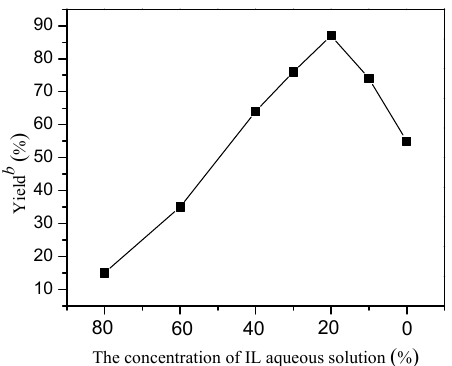
Figure 2. Reaction yield in IL aqueous solutions with different concentrations a . a Reaction conditions : 2-aminoacetophenone (0.3 mmol), ethyl acetoacetate (0.36 mmol), and α -chymotrypsin (10 mg) in IL aqueous solutions of different concentrations (80 to 0%, [EMIM][BF 4 ]/(H 2 O + [EMIM][BF 4 ]), v / v ) at 60 °C for 24 h. b Isolated yield after column chromatography.